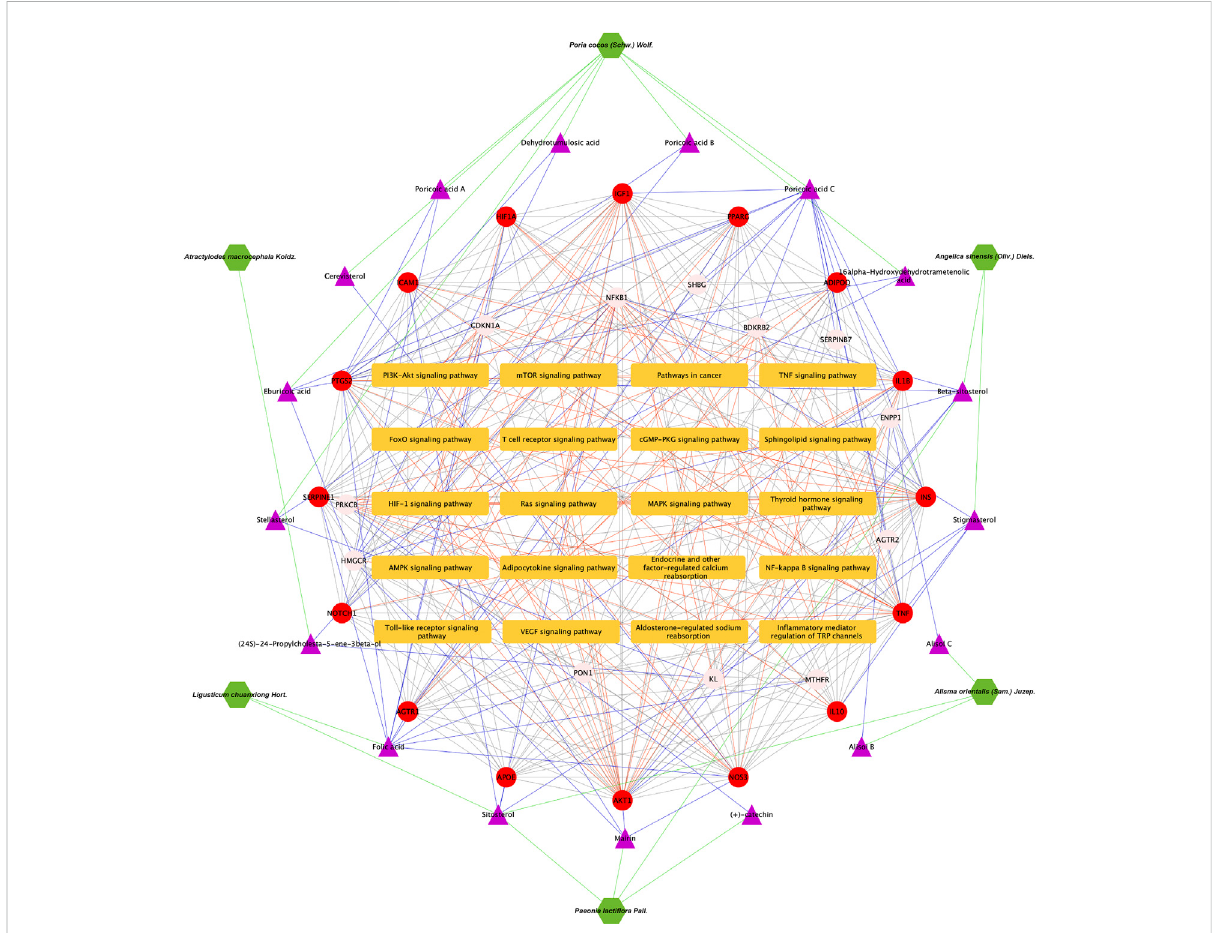
FIGURE 8 Herbs-active ingredients-common targets-enriched KEGG pathways network. Green hexagons represent herbs of DSS, the purple triangles represent screened active ingredients of these herbs, the red circles represent the 16 core common targets of DSS and DKD, pink circles represent othercommontargets,andtheorangerectanglesrepresentenrichedKEGGpathways.Thegreenlinesrepresenttheinteractionsbetweenherbsand the chemical ingredients, the blue lines represent the interactions between ingredients and the common targets, the red lines represent interactions between the common targets and KEGG pathways, while the protein-protein interactions were represented as prey